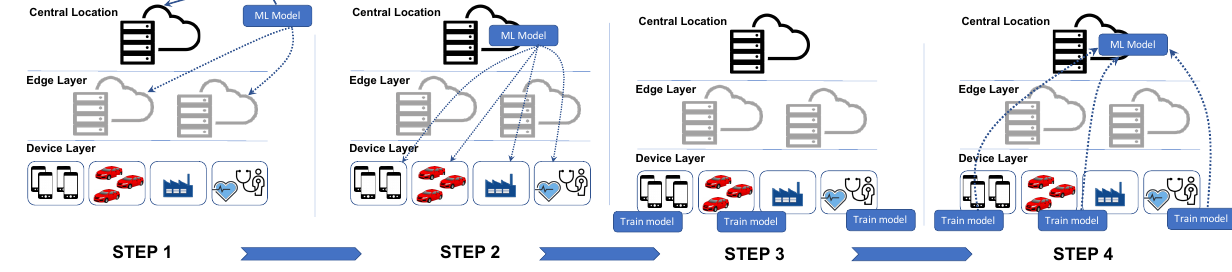
Figure 4. Steps of Federated